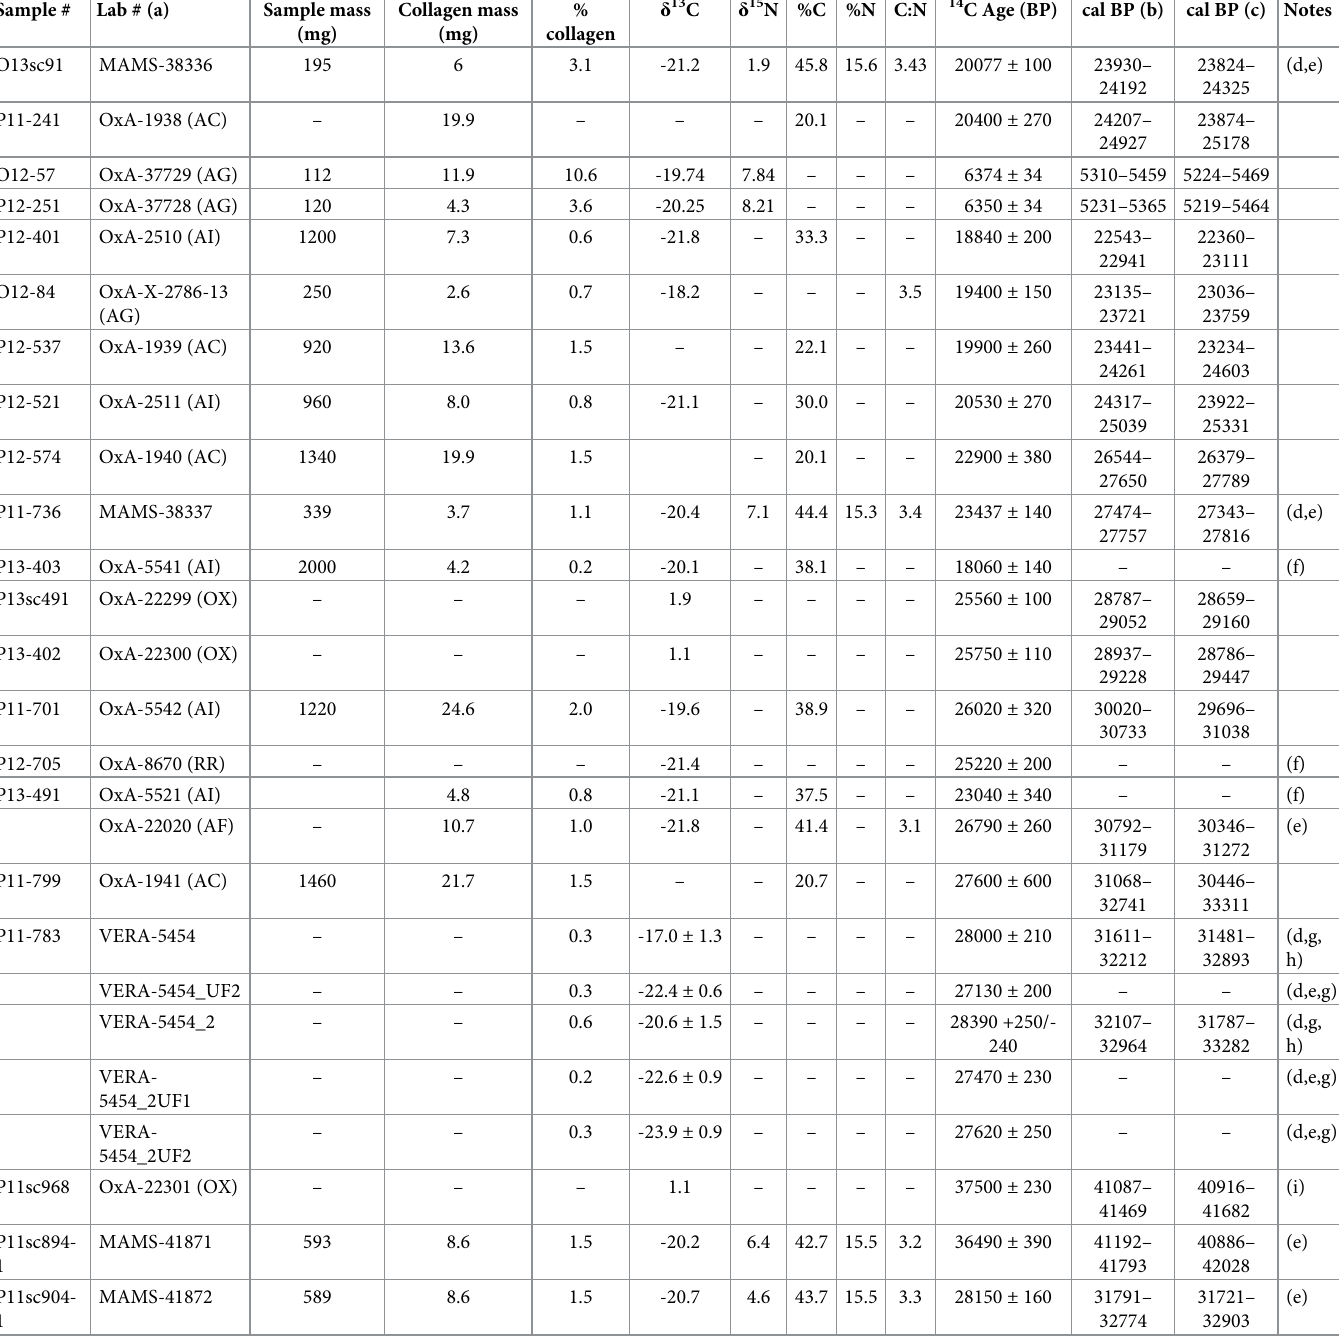
Table 5. AMS radiocarbon dating of the pleistocene deposit in back chamber and corridor: